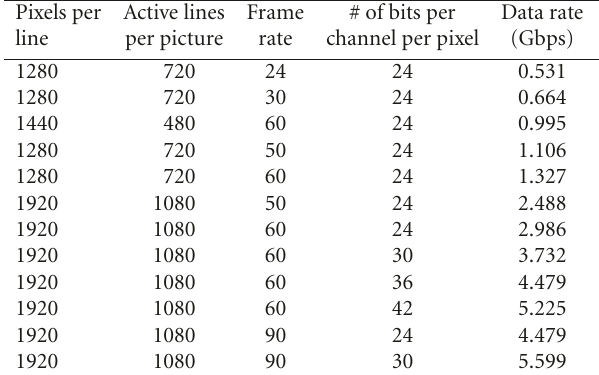
Table 2: Data rate requirements for di ff erent resolutions, frame rates, and numbers of bits per channel per pixel for HDTV stan- dard. Pixels per Active lines